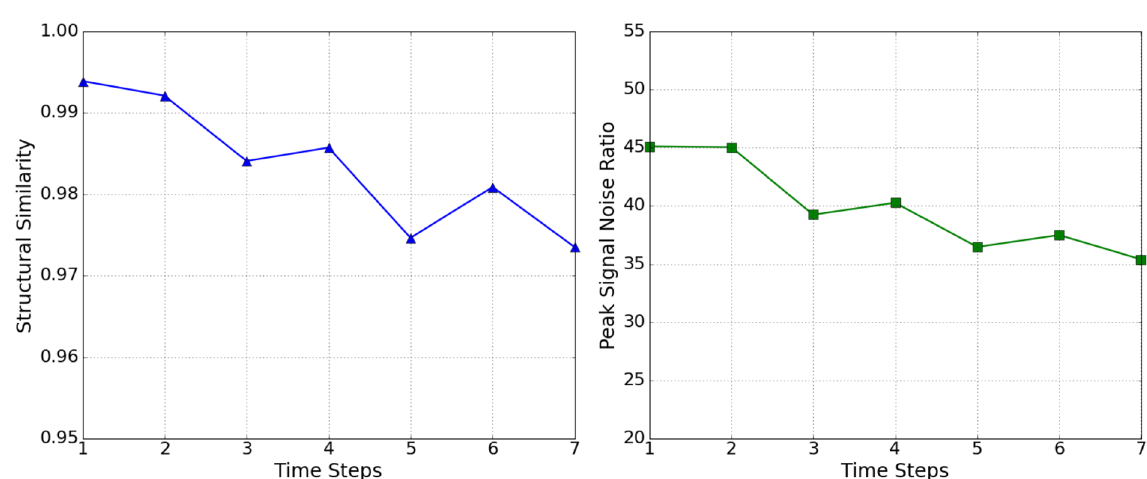
Figure 2. Frame wise average SSIM scores (on the left) and PSNR scores (on the right) over the 135 test